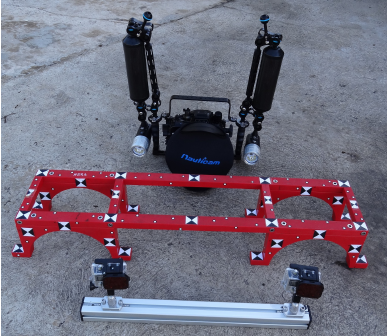
Figure 1. Calibration frame with camera systems Lumix GH4 and the GoPro Hero4 stereo camera